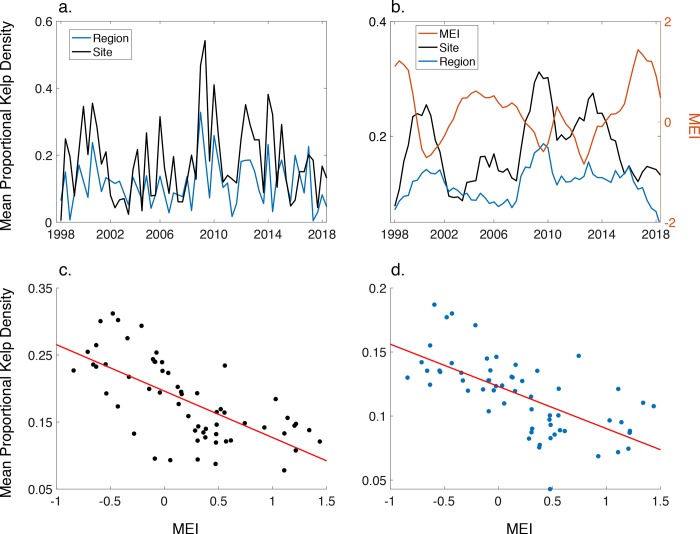
Kelp canopy density from Landsat imagery.a) Mean proportional kelp canopy density at the trimester time scale for both site (black) and regional (blue) scales. b) Mean proportional kelp canopy density with a 2-year running mean at both the site (black) and regional (blue) scales along with the 2-year running mean of the NOAA Multivariate ENSO Index (MEI), lagged by one year. c) Relationship between the site scale mean proportional kelp canopy density and MEI shown in b. Red line shows the linear fit between the variables. d) Relationship between the regional scale mean proportional kelp canopy density and MEI shown in b. Red line shows the linear fit between the variables.